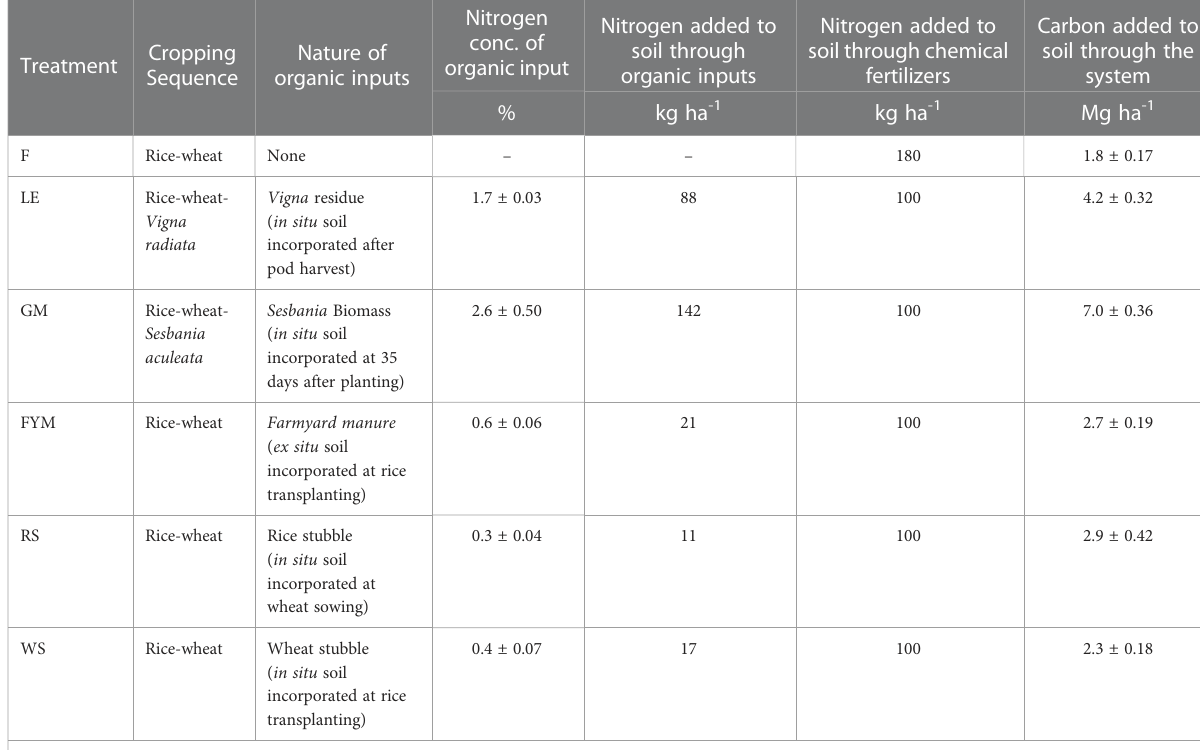
TABLE 1 The nitrogen and carbon added to the soil through each management system (conventional and integrated nutrient